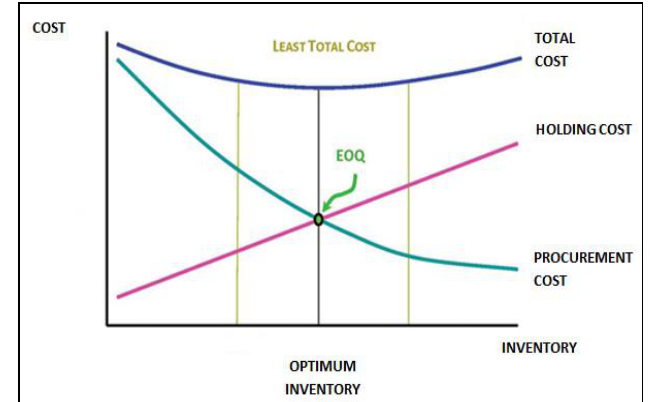
Fig 2. Inventory level and cost